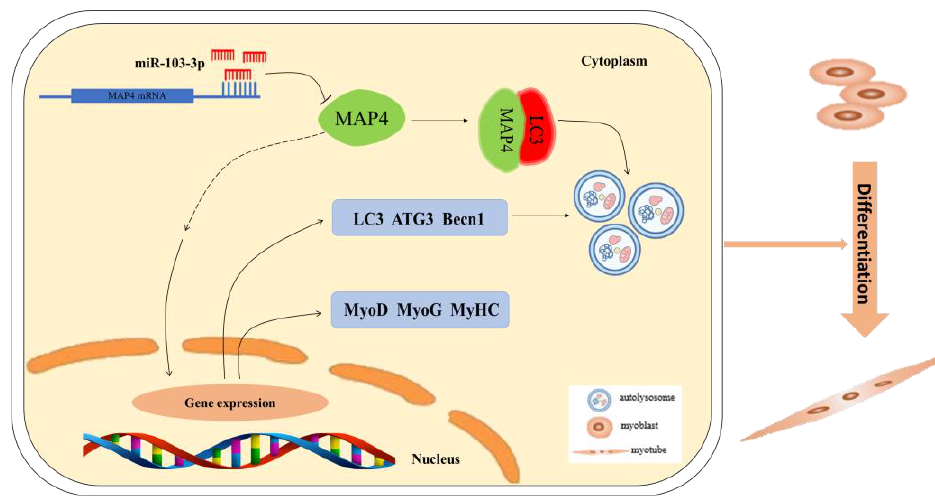
Figure 8. Schematic diagram of the miR-103-3p/MAP4 axis mediating myoblast differentiation and autophagy. miR-103- 3p targets MAP4 3′UTR to regulate MAP4 expression , thus mediating differentiation and autophagy of myoblasts.